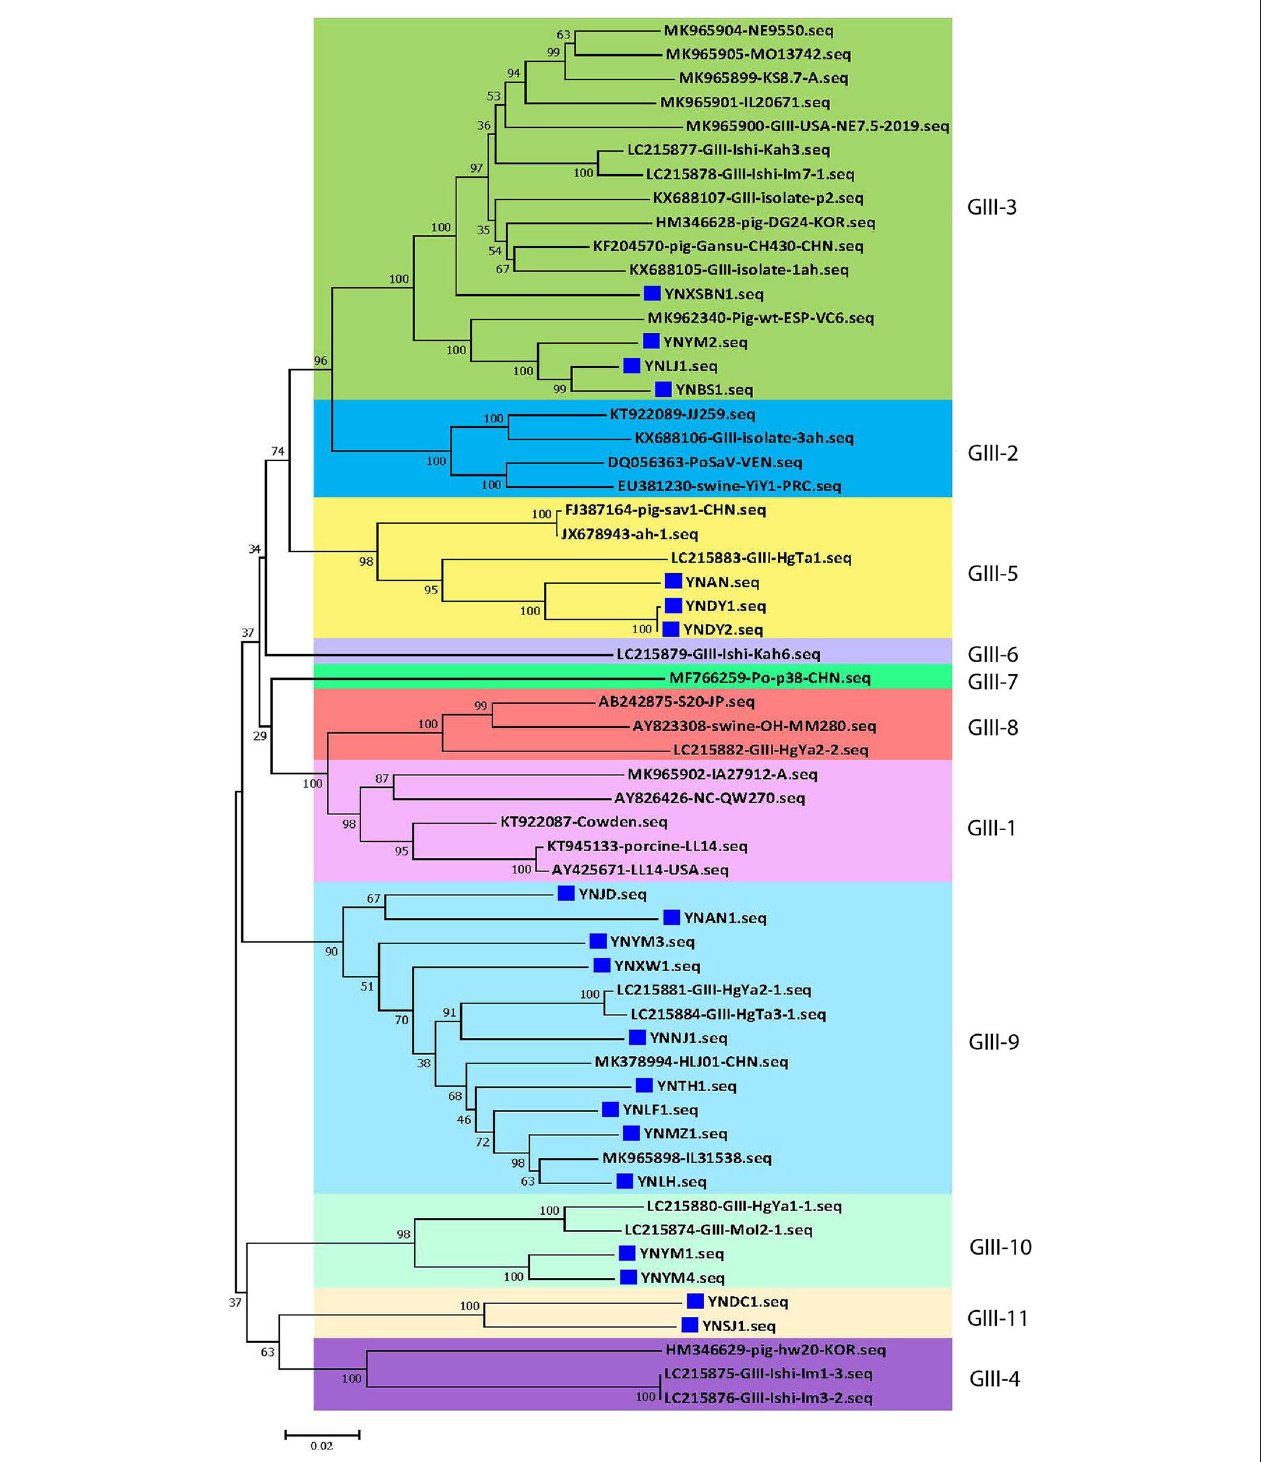
FIGURE 2 | The 20 Yunnan PoSaV-GIII strains fell into 5 genotypes by phylogenetic analysis of the capsid genes ( VP1 and VP2 ), including 38 reference sequences retrieved from GenBank ( Supplementary Table S3 ). The phylogenetic trees were constructed by neighbor-joining (NJ) method. Significant bootstrap values are indicated as a percentage for 1,000 replicates. Bootstrap values higher than 50 are displayed along the relative branches. Different genotypes are color coded. The blue squares represent the PoSaV sequences obtained in this study from Yunnan. The numbers in the trees indicate the confidence and the bars under the trees indicate the phylogenetic